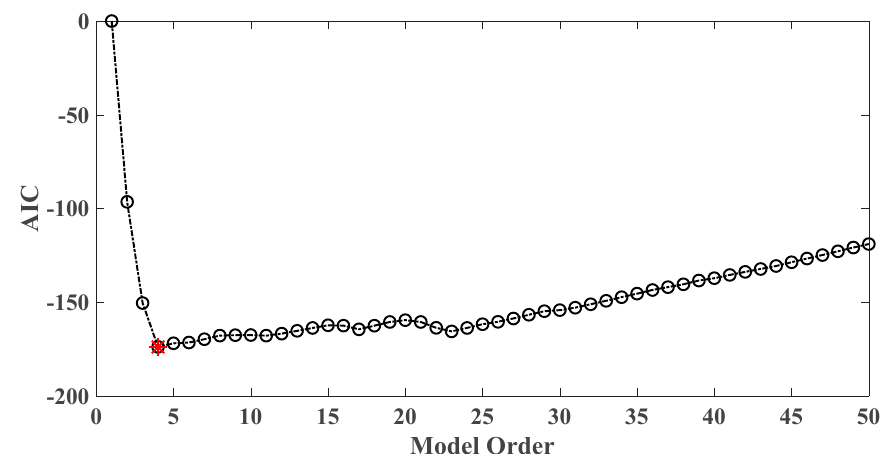
Figure 29. AIC of an AR model for the third floor response under the case of removing braces on the third floor.